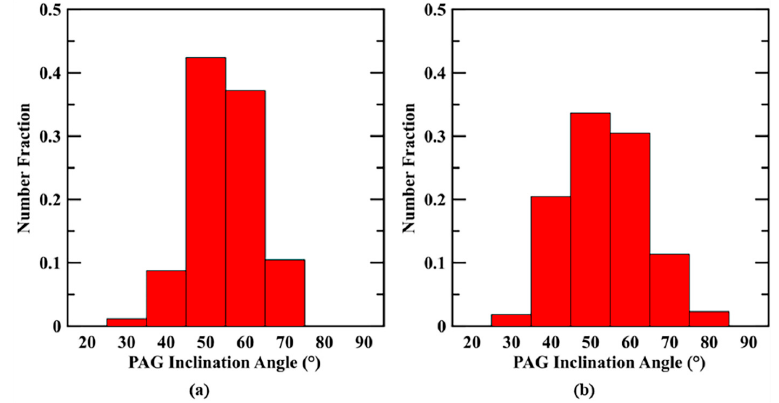
Figure 13. Prior austenite grain (PAG) inclination angle histograms for microstructures produced via Low T Finish simulations: ( a ) quenched after the fourth finishing deformation step (F4) and ( b ) quenched after the final finishing deformation step (F7). Data were obtained at the 0.724 radial position for both cases.